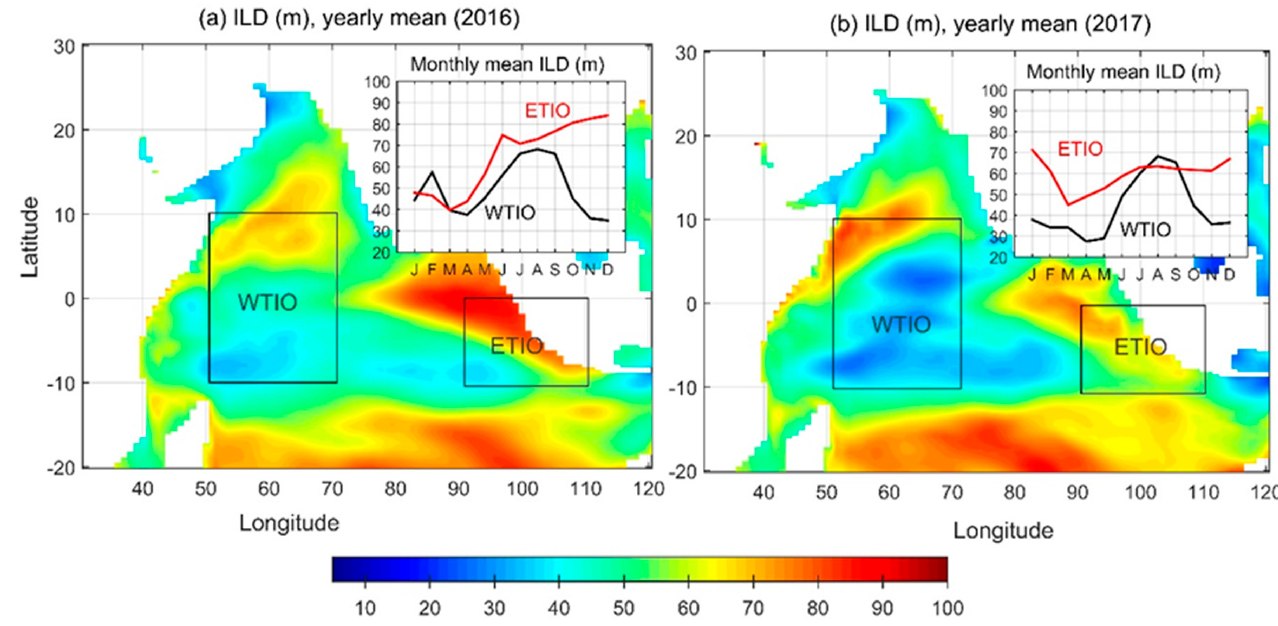
Figure 7. As in Figure 6, but for isothermal layer depth (ILD) in 2016 ( a ) and 2017 ( b ). The changes in the thermocline depth are reflected by the changes in the ILD. Data obtained from GODAS.